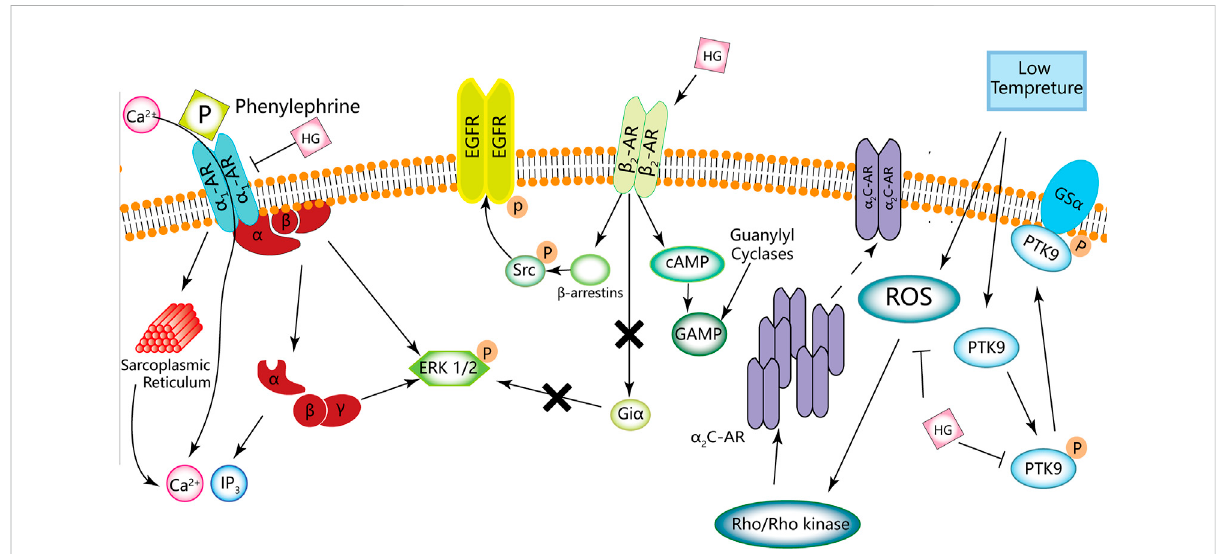
FIGURE 5 Adrenergic effects of HG. HG may act as a β -AR agonist and an α -AR